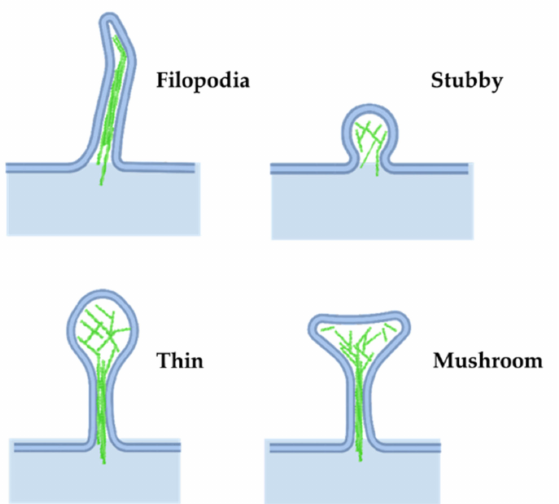
Figure 5. Dendritic spine morphology. Actin networks influence different structures in dendritic spines. Adapted from “Axonal-dendritic synaptic cleft and Protruding membrane”, by https:// BioRender.com (accessed on 26 January 2022) (2020). Created and retrieved from https://app. biorender.com/biorender-templates (accessed on 26 January